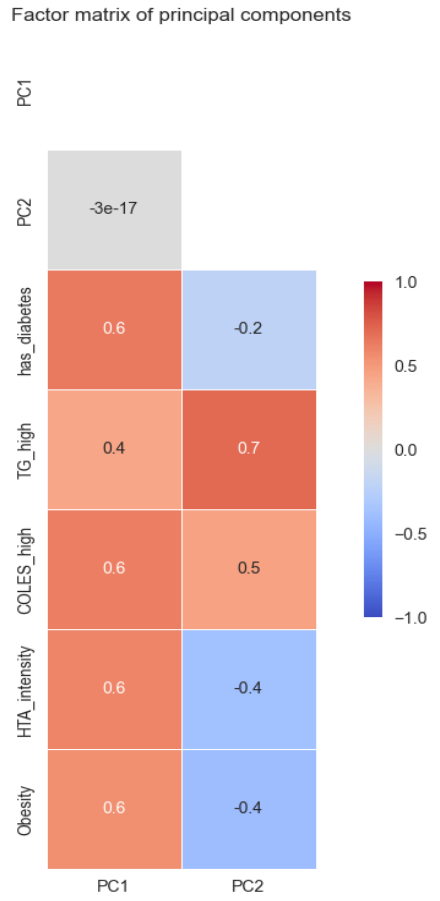
Figure 8. Factor matrix of the principal components.